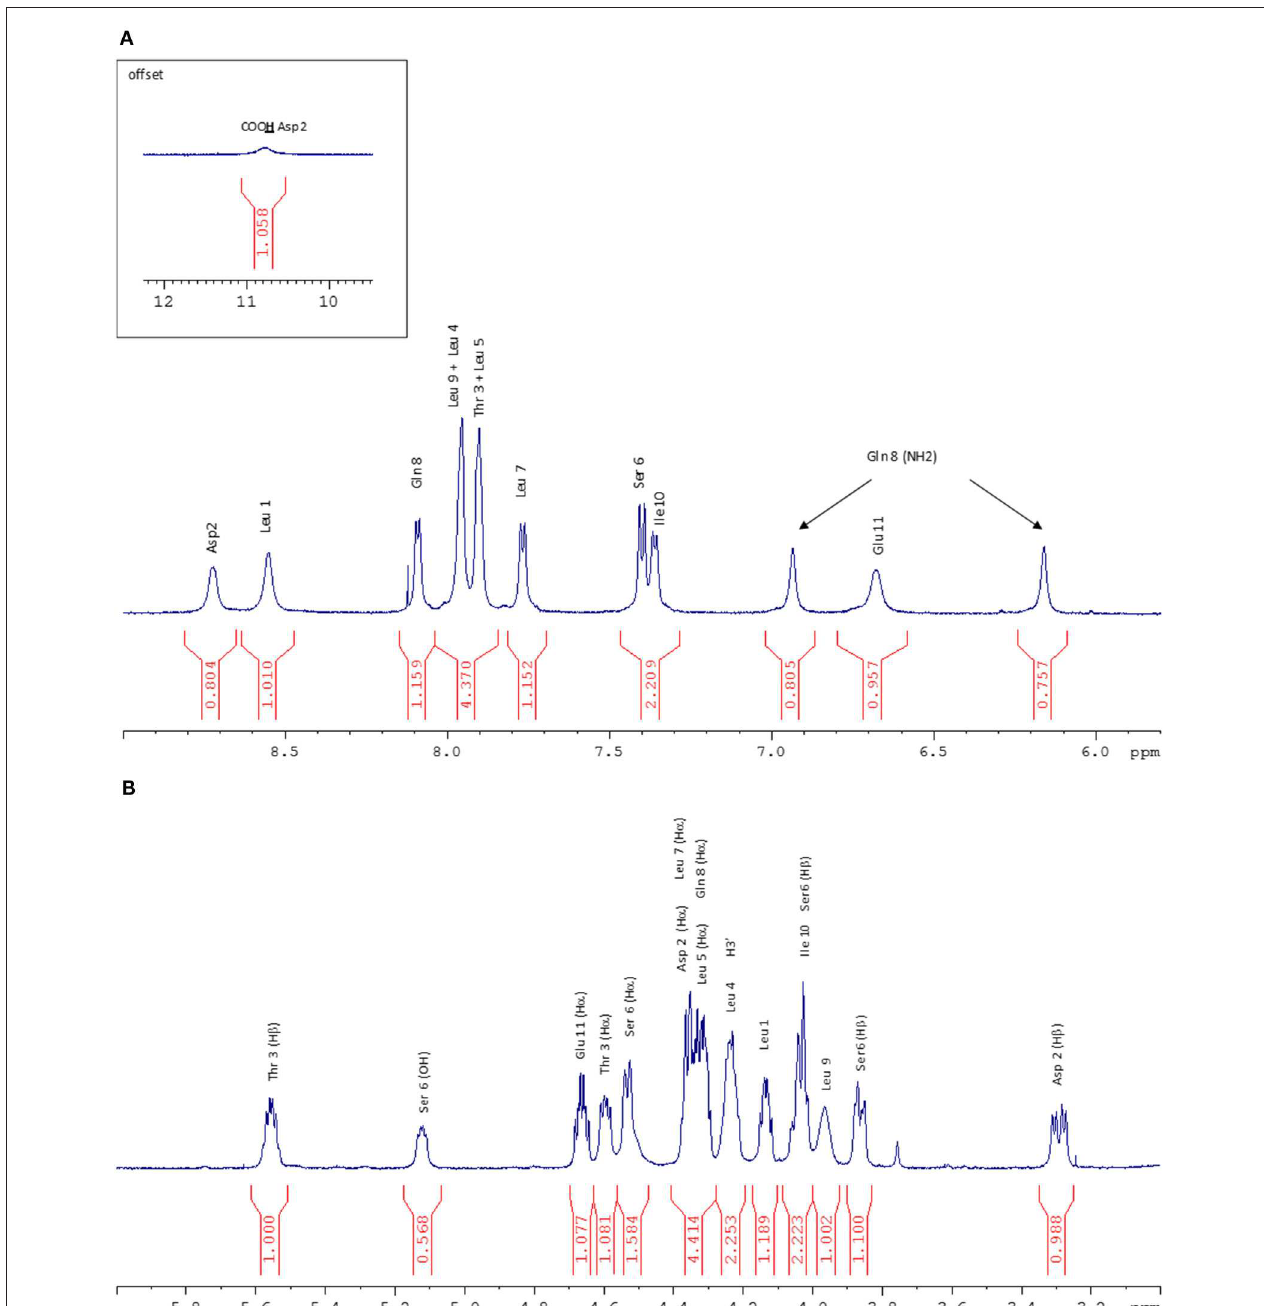
FIGURE 5 | (A) NH zone of the 1 H NMR spectrum (600 MHz, 298K, Acetone-d 6 ). (B) H α zone of the 1 H NMR spectrum (600 MHz, 298K, Acetone-d6).